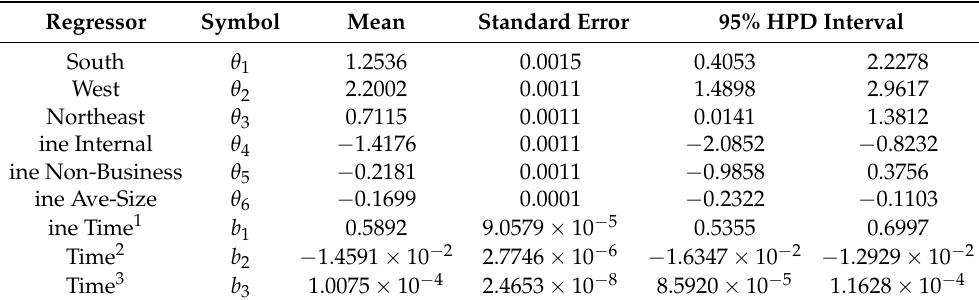
Table 5. Posterior summary and interval